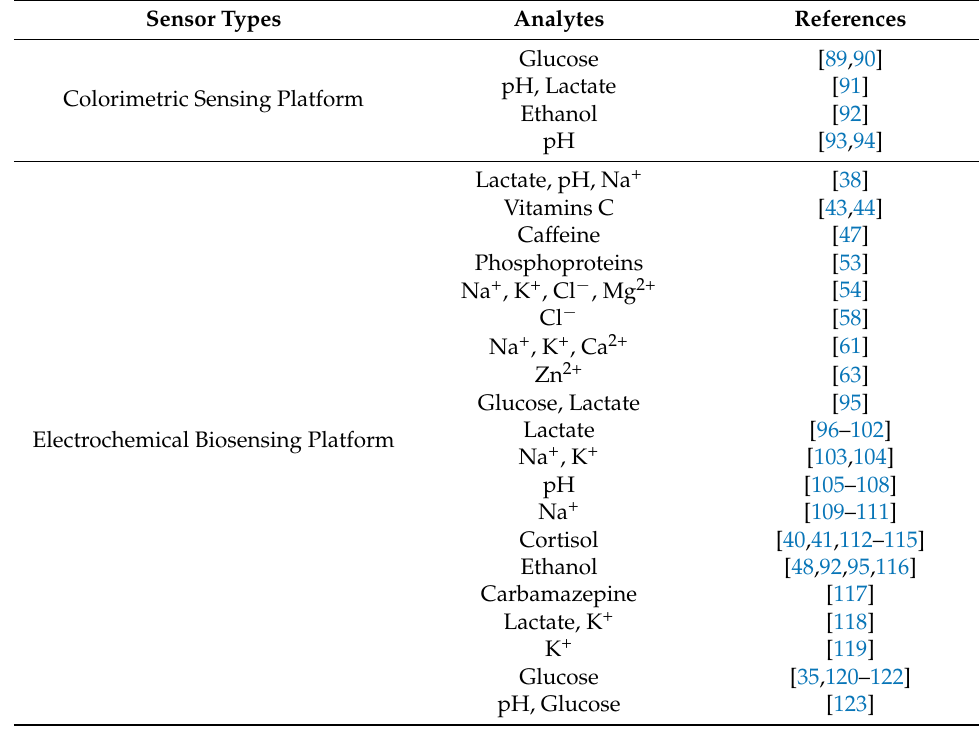
Table 2. The types of sweat wearable sensors and the related analytes in the